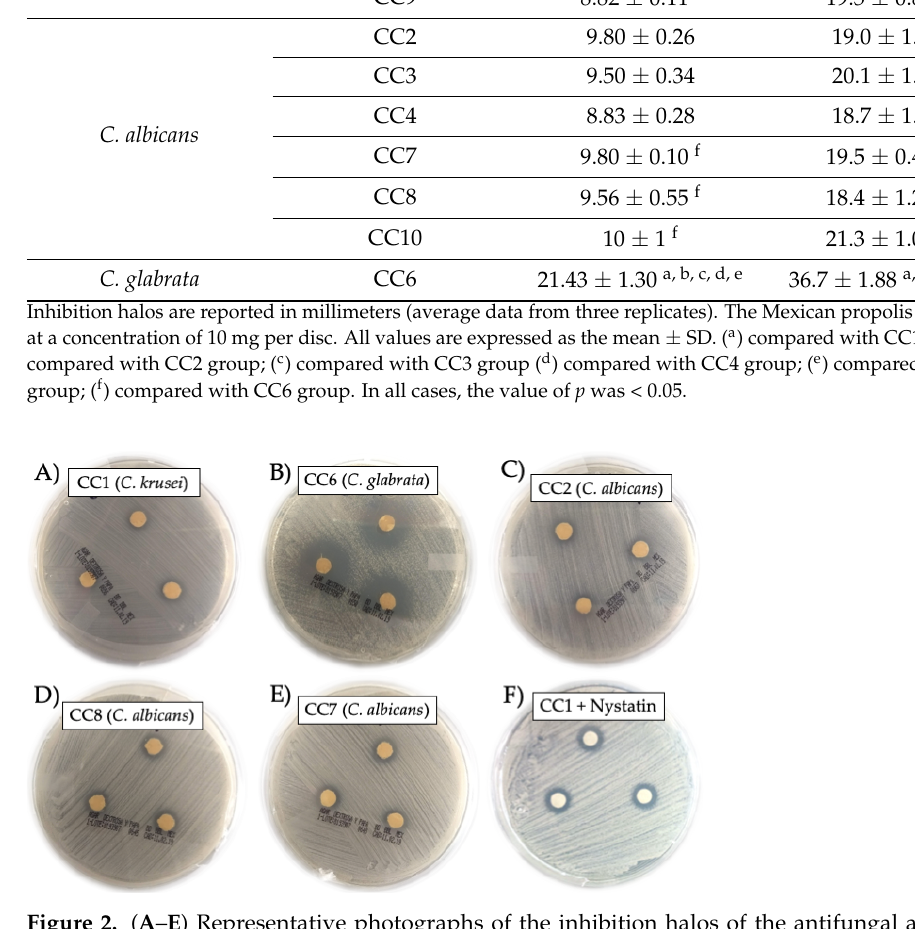
Figure 2. ( A – E ) Representative photographs of the inhibition halos of the antifungal activity of Mexican propolis against different species of Candida . ( F ) Representative photograph of the inhibition halos of Nystatin against CC1 ( C. krusei ).